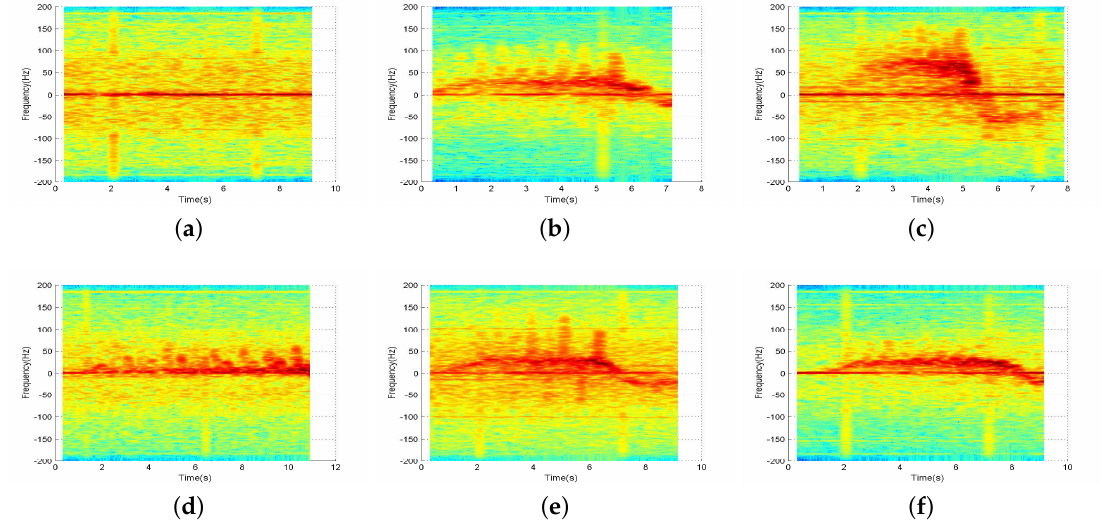
Figure 9. The time-frequency analysis results of six motion states. ( a ) sitting still; ( b ) walking with both arms; ( c ) running; ( d ) crawling; ( e ) walking with a single arm; ( f ) walking without